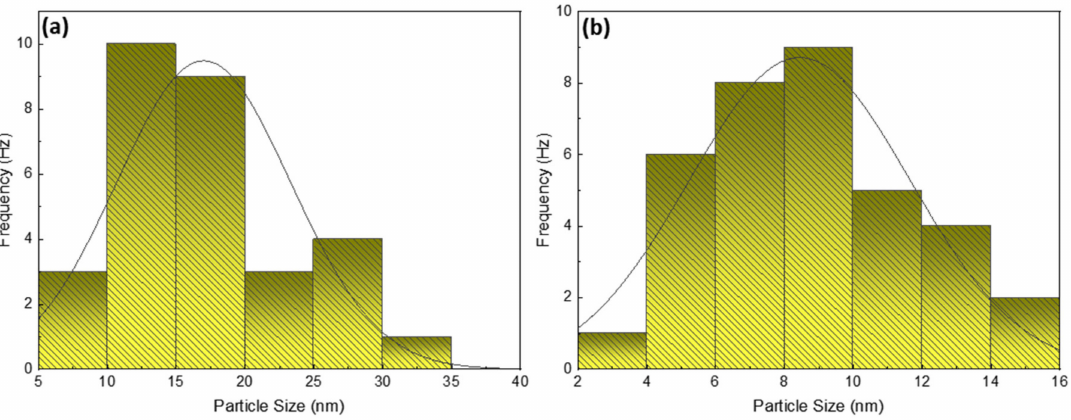
Figure 7. Histogram depicting size and frequency of mediated AgNPs particles at a scale of 200 nm ( a ) leaf extract ( b ) fruit